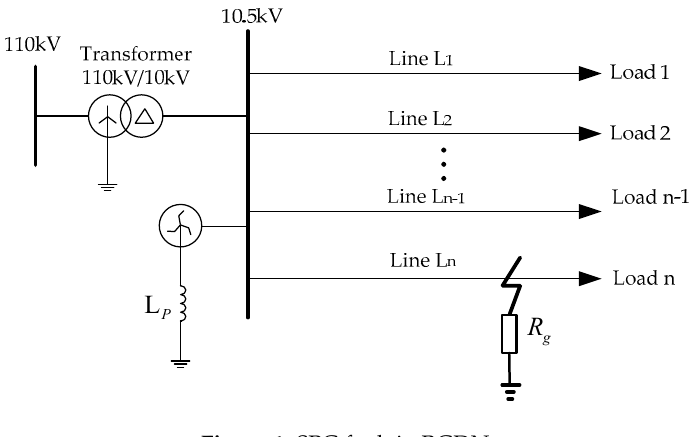
Figure 1. SPG fault in RGDN.